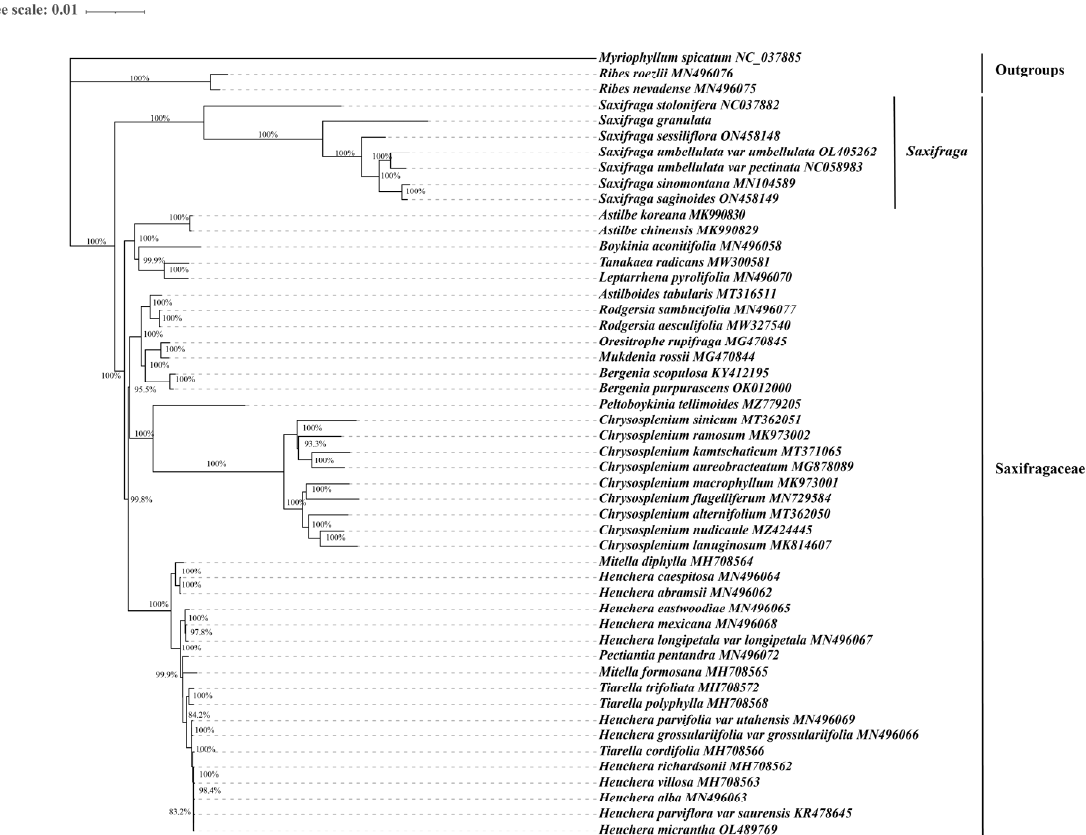
Figure 7. Maximum likelihood (ML) phylogenetic tree of 47 species in the Saxifragaceae family, reconstructed with 79 PCGs. Three non-Saxifragaceae species, Myriophyllum spicatum, Ribes nevadense, and Ribes roezlii, were set as